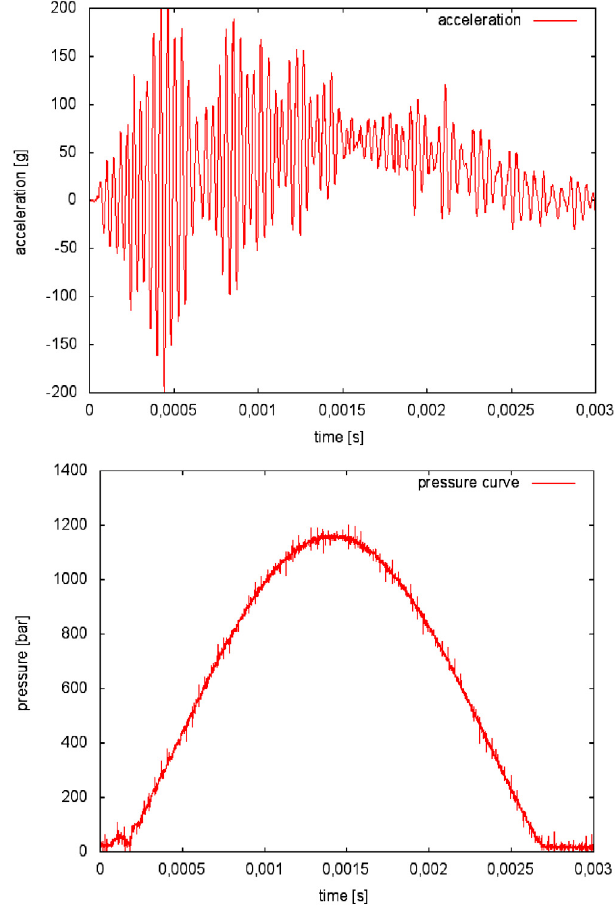
Fig. 10. Acceleration and pressure curves.